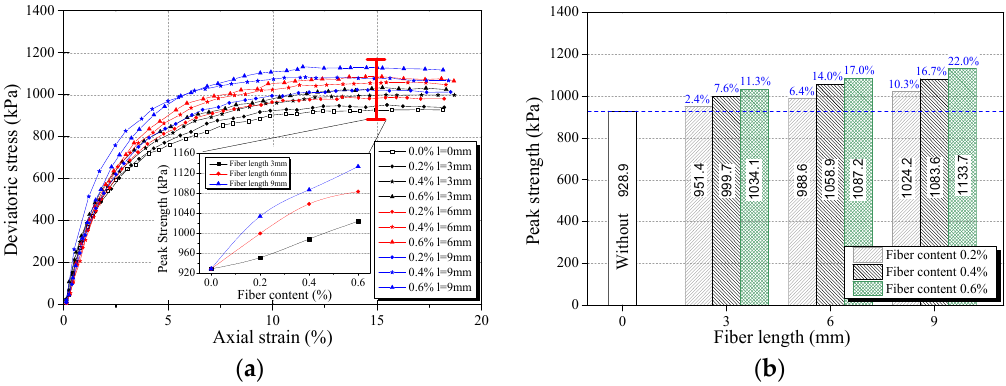
Figure 8. Stress strain curve and peak strength of fiber-reinforced tailings sand ( ρ d = 1.59 g·cm − 3 ). ( a ) Stress-strain curve, ( b ) peak strength increment of BFRT.